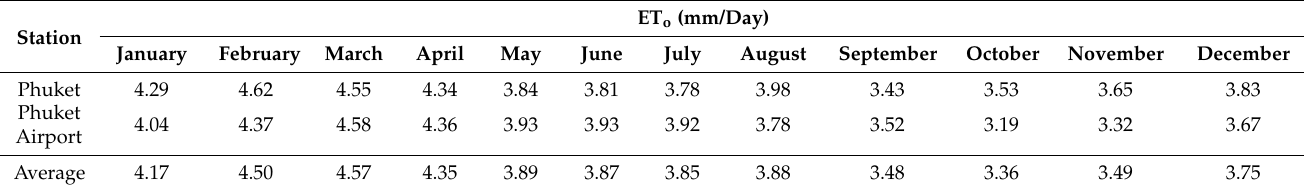
Table A2. The reference evapotranspiration under the Penman–Monteith